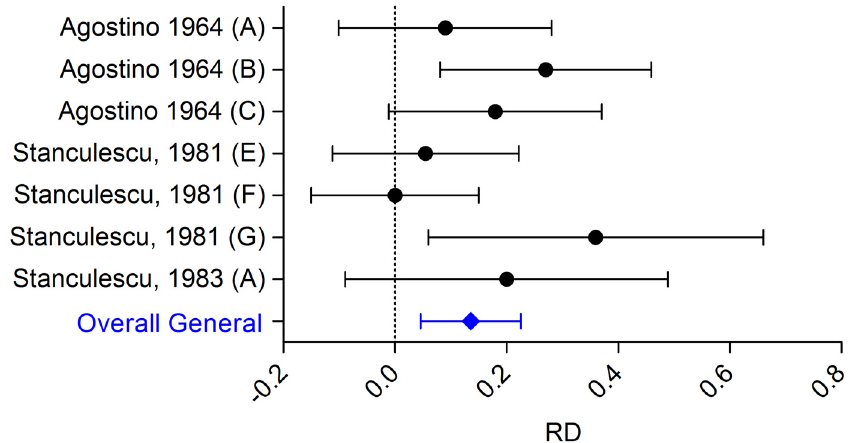
Fig 5. Forest plot of the impact of general anaesthetics on the incidence of metastases. Left side is reduced incidence of metastases, right side equals increased incidence of metastases. General anaesthetics increase the incidence of metastases. Data are presented as Risk Difference (RD) and 95%